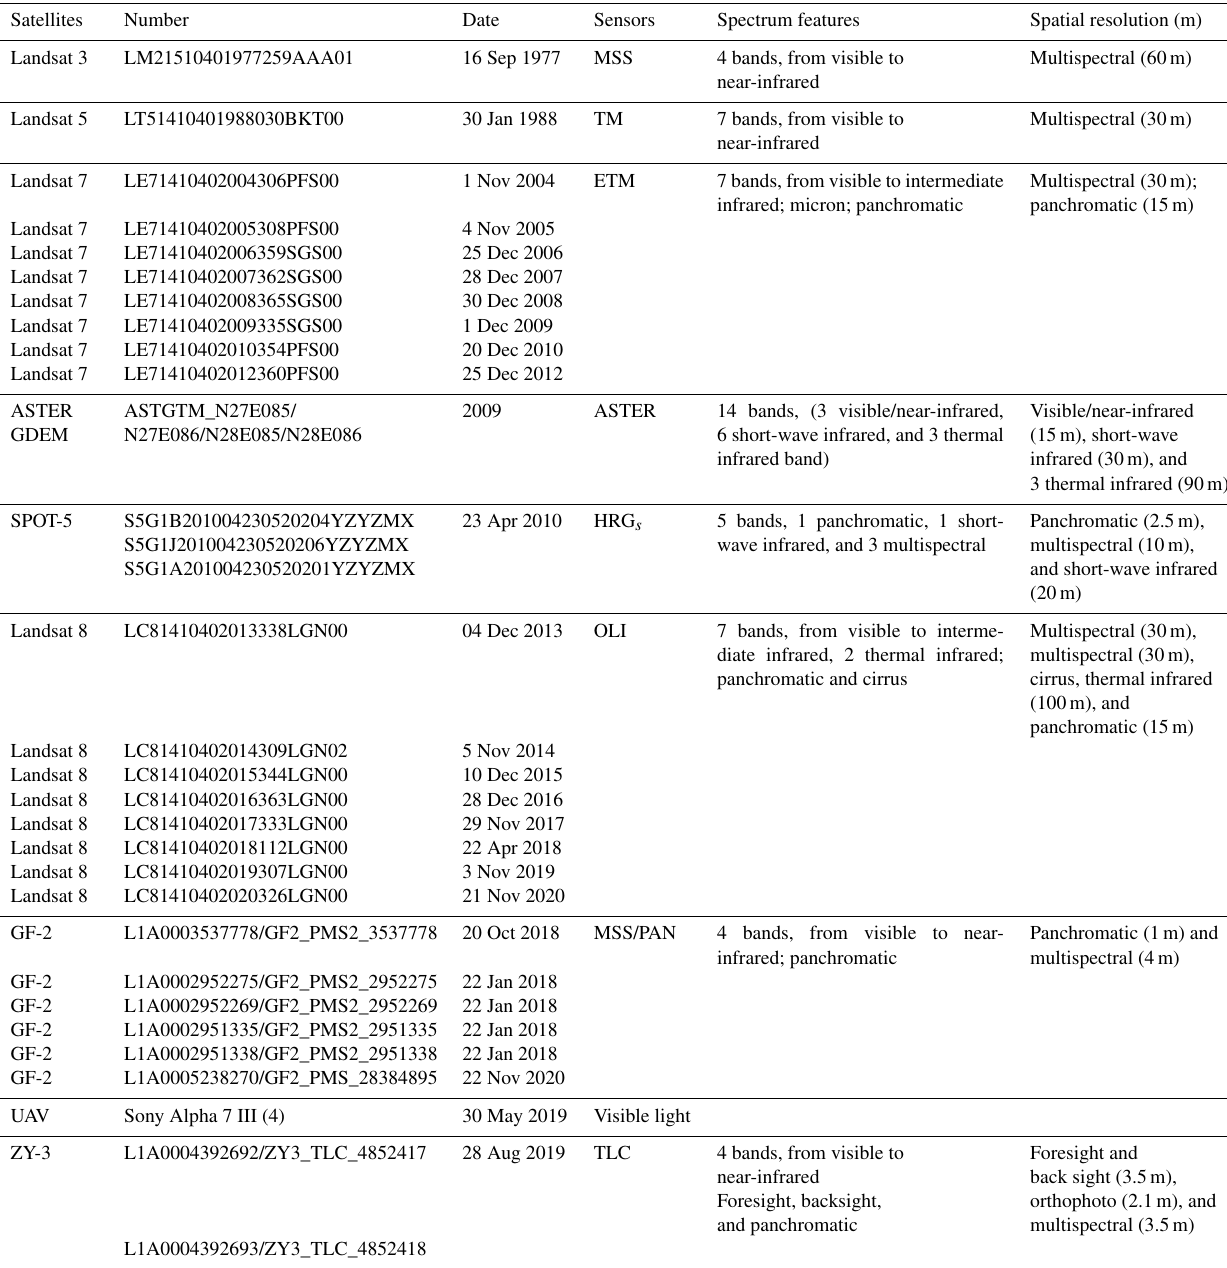
Table 1. Data sources and features for the interpretation of glaciers and glacial